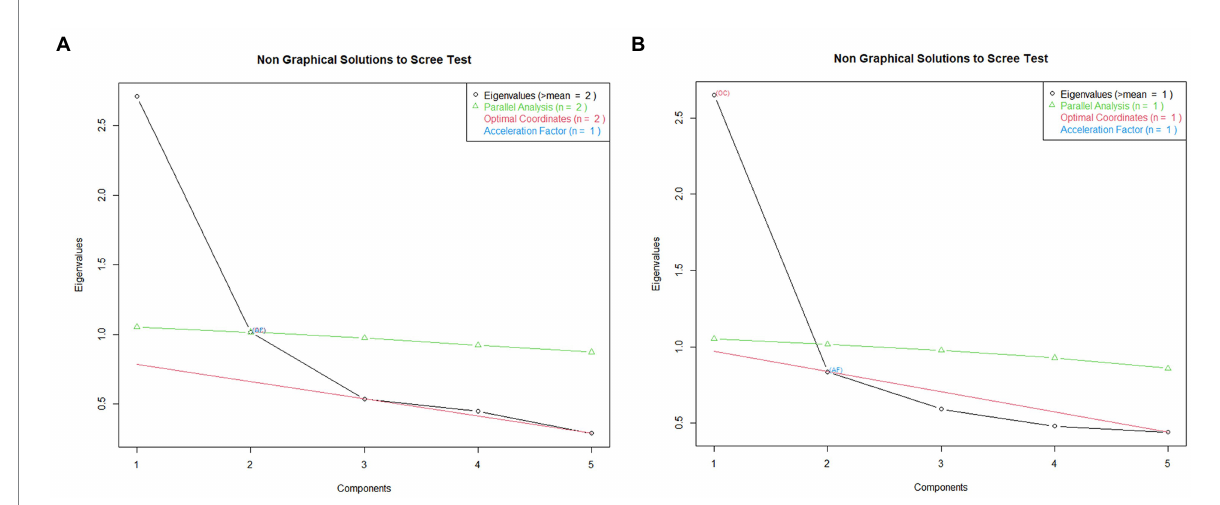
FIGURE 1 Scree plot of the EFA: (A) Material Scarcity factors; (B) Socio-Psychological Scarcity factors.